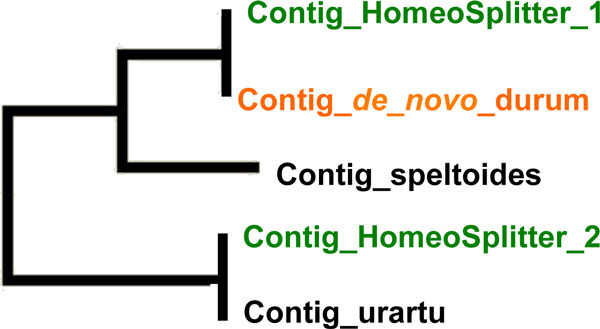
Phylogenetic tree inferred on homologous contigs from cluster 6960. The original contig obtained by de novo assembling (contig_de_novo_durum) was more similar to the speltoides contig (contig_speltoides) than to the urartu one (contig_urartu). After using HomeoSplitter we obtained the most expressed split contig (contig_HomoeoSplitter_1) that is still similar to the speltoides one and one less expressed contig (contig_HomoeoSplitter_2) highly similar to the urartu one.